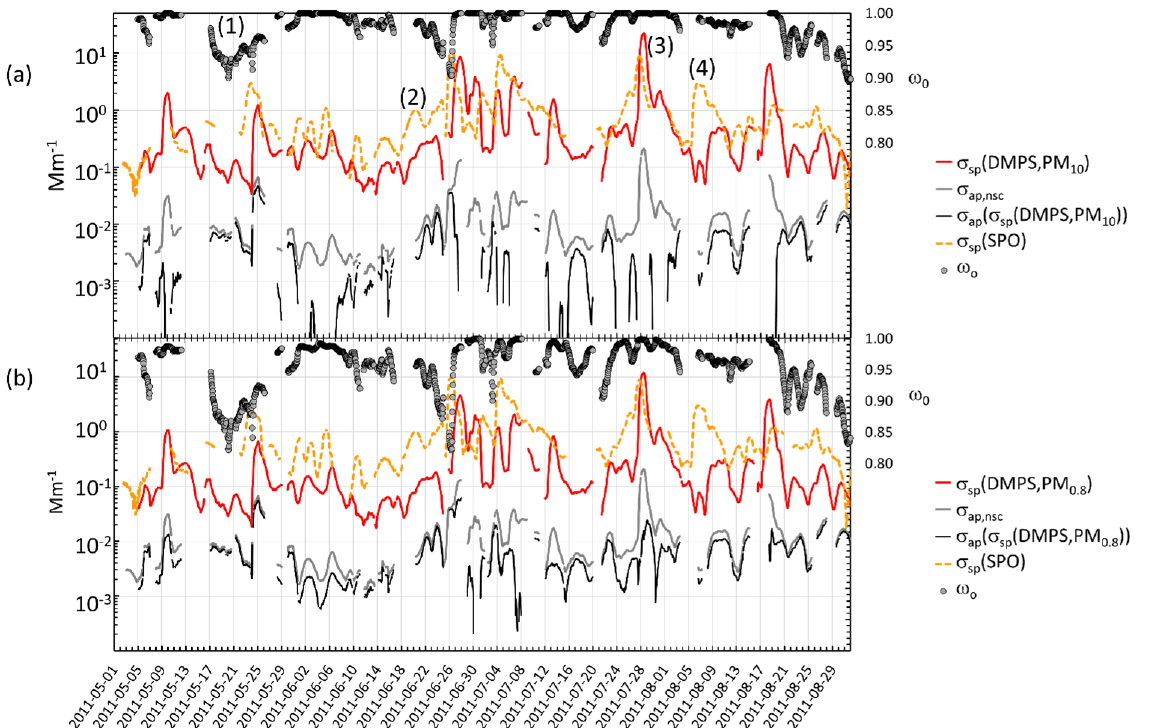
Figure 6. Four-month time series (May–August 2011) of σ sp , σ ap and ω o at λ = 530nm at Dome C and σ sp at λ = 550nm at the SPO: (a) upper estimate of σ sp ( = σ sp (DMPS,PM 10 )), lower estimate of σ ap ( = σ ap ( σ sp (DMPS, PM 10 ))), and upper estimate of ω o . (b) Lower estimate of σ sp ( = σ sp (DMPS, PM 0 . 8 ))), upper estimate of σ ap ( = σ ap ( σ sp (DMPS, PM 0 . 8 ))), and lower estimate of ω o . In both (a) and (b) the non-scattering-corrected absorption coefficient is also shown. All values are running 24h averages at each hour ( ± 12h). The numbers 1–4 are discussed in the